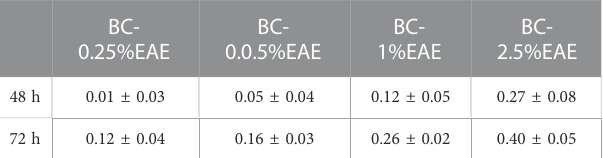
TABLE 3 The total polyphenol concentration (mmol/dm3) released from BC- EAE to the medium after 48 and 72